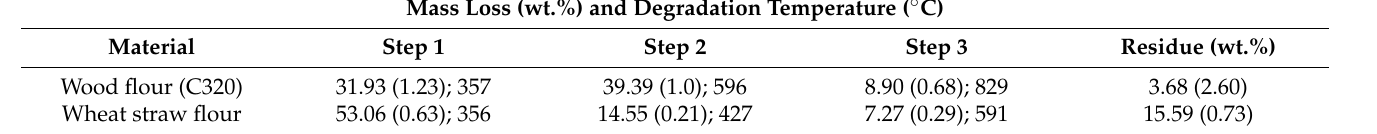
Figure 17. Thermal degradation steps for wood flour (Arbocel C320). Table 11. TGA results for wheat straw and wood particles. Values represent the average of three measurements (standard deviation in parentheses).